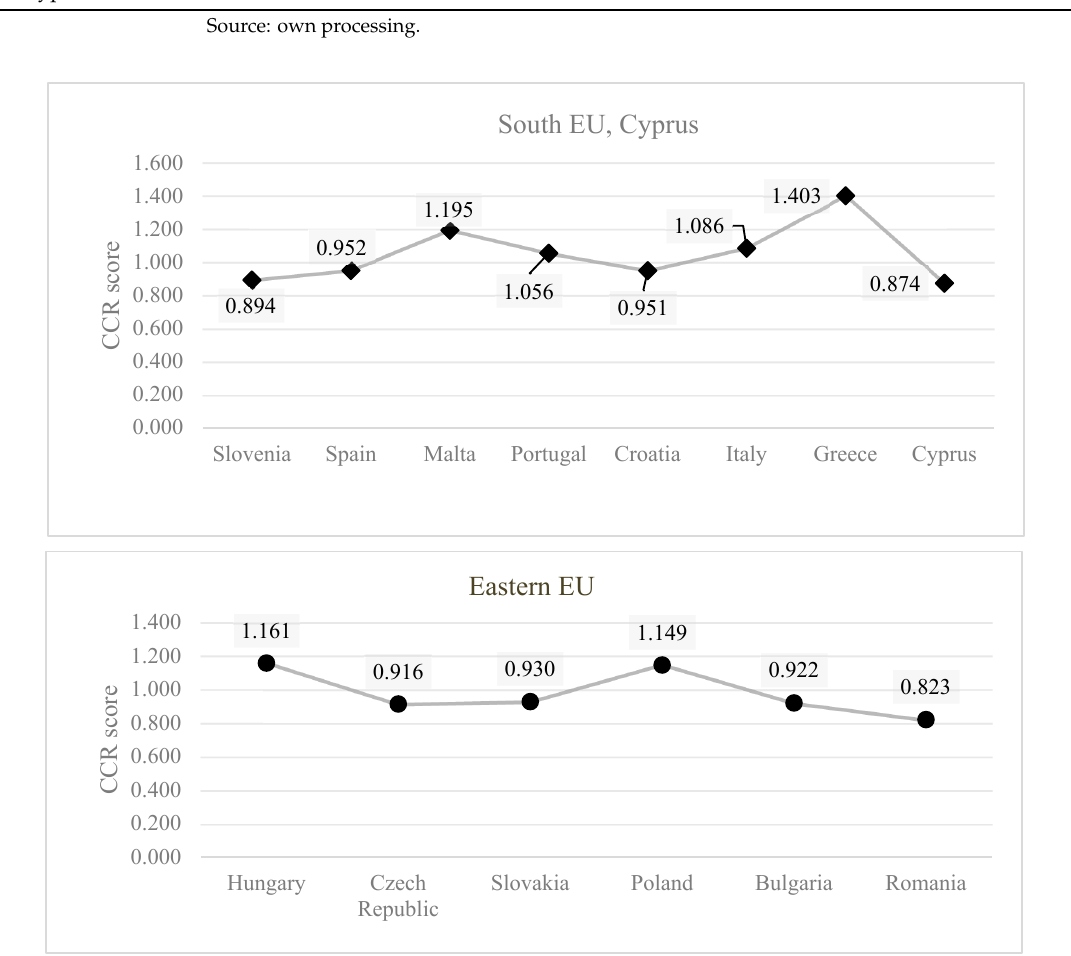
Figure 6. CCR model results across Northern, Eastern, and Southern EU. Source: own processing. Table 13 shows that not every output needs to be changed for the country to become efficient. For some countries, one output needs to be modified, but for others, two out of three The differences between countries are evident; in order to become effective and achieve a score of 1 in the DEA analysis a country needs to adjust outputs. For this outputs need to be modified. Countries that are efficient do not need to modify any output. Table 13. Changing outputs to achieve e ffi ciencies.